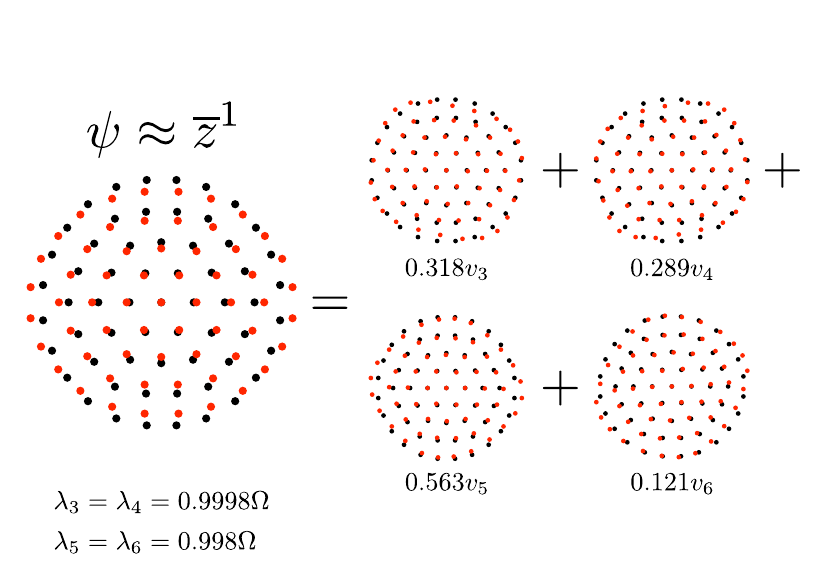
Figure 5: For N = 61 = C , the mode ψ ≈ z 1 is constructed as a linear combination 5 of the third through sixth eigenvectors, whose corresponding eigenvalues are close, but not exactly equal, to Ω . If we were instead to fit az 1 , where a ∈ (cid:67) was arbitrary, the relative magnitude of the four contributions would change, but the same four eigenvectors would produce the mode. Note that the first and second eigenvectors correspond to uniform translations ( ψ ∼ z 0 ) and are always exact eigenvectors with eigenvalue Ω .